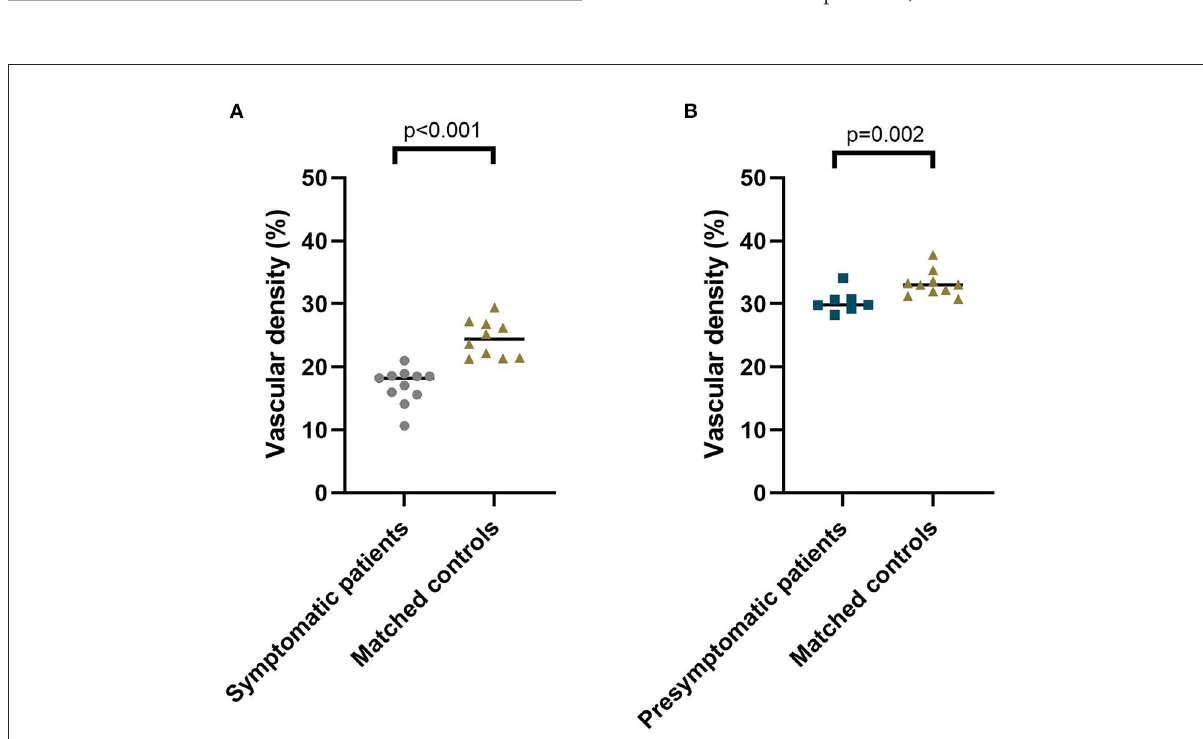
FIGURE3 Median vascular density of the superficial capillary networks in symptomatic RVCL-S patients and controls (A) and presymptomatic RVCL-S patients and controls (B)